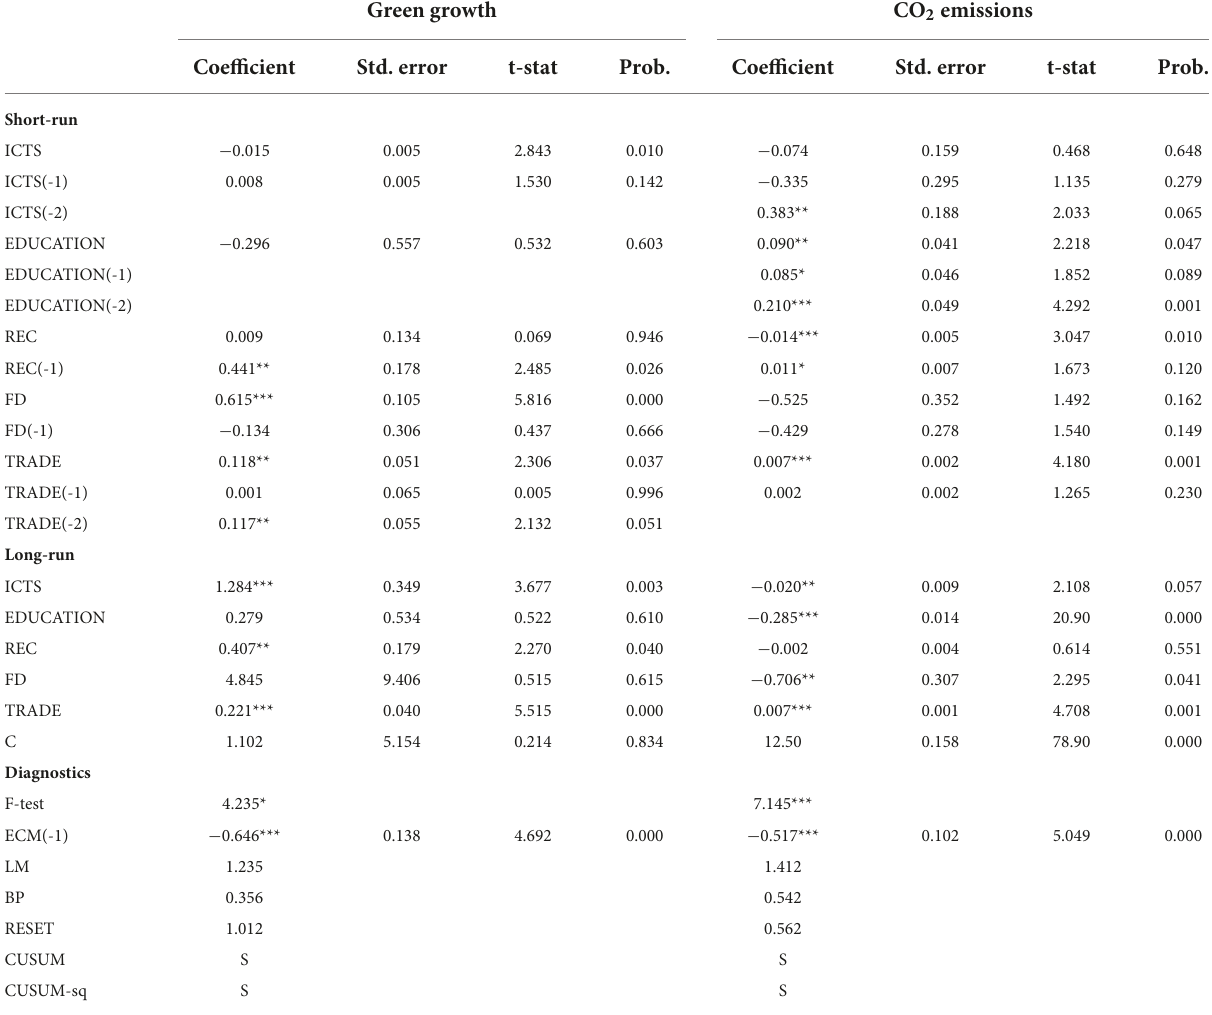
TABLE 3 ARDL estimates of green growth and CO 2